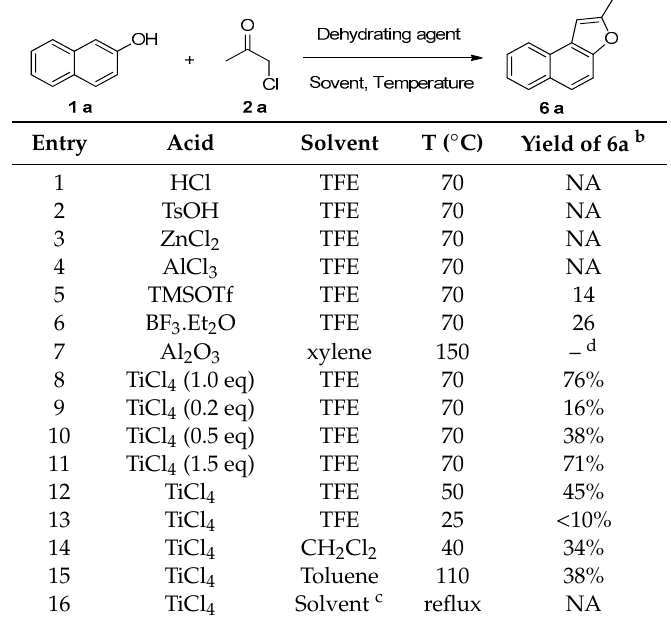
Table 1. Model reaction optimization a .